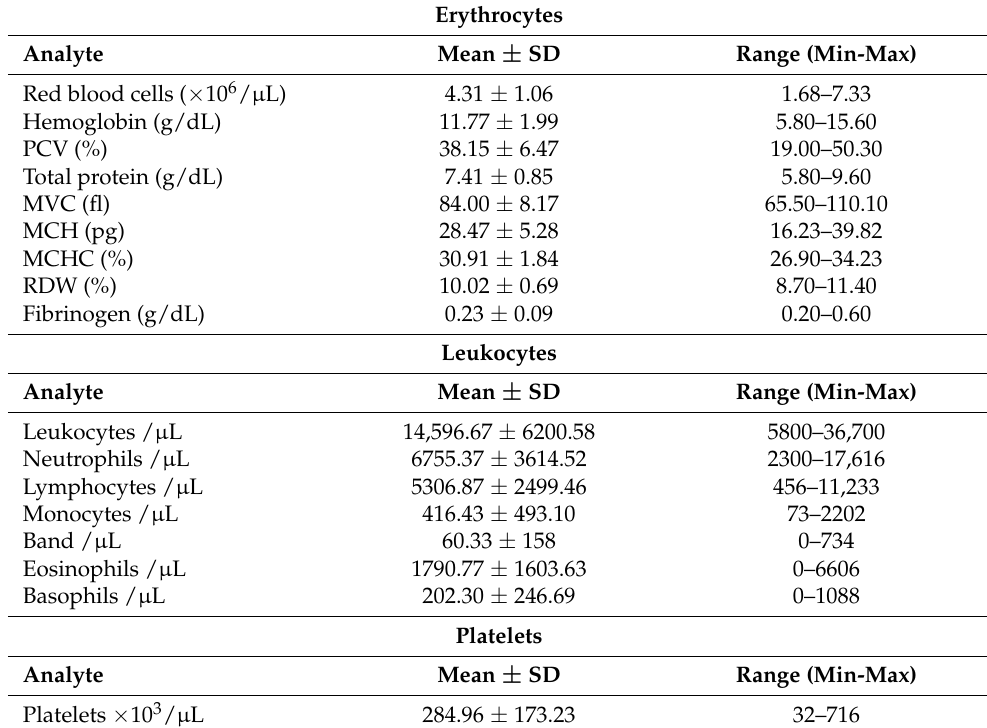
Table 1. Mean, standard deviation and range of complete blood count (CBC) and serum biochemical results of black-eared opossums ( Didelphis aurita ) ( n = 30).